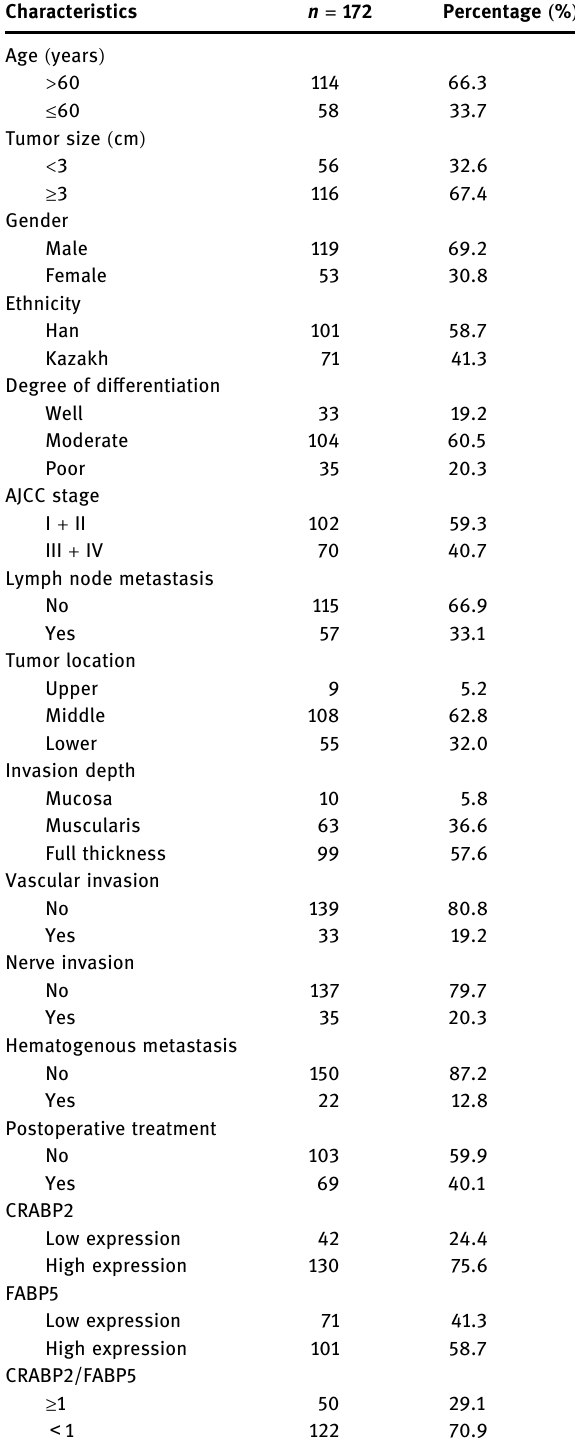
Table 1: General characteristics of ESCC patients